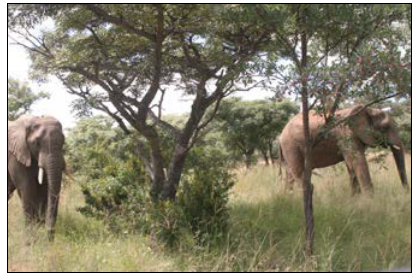
Figure 6: Welgevonden Private Nature